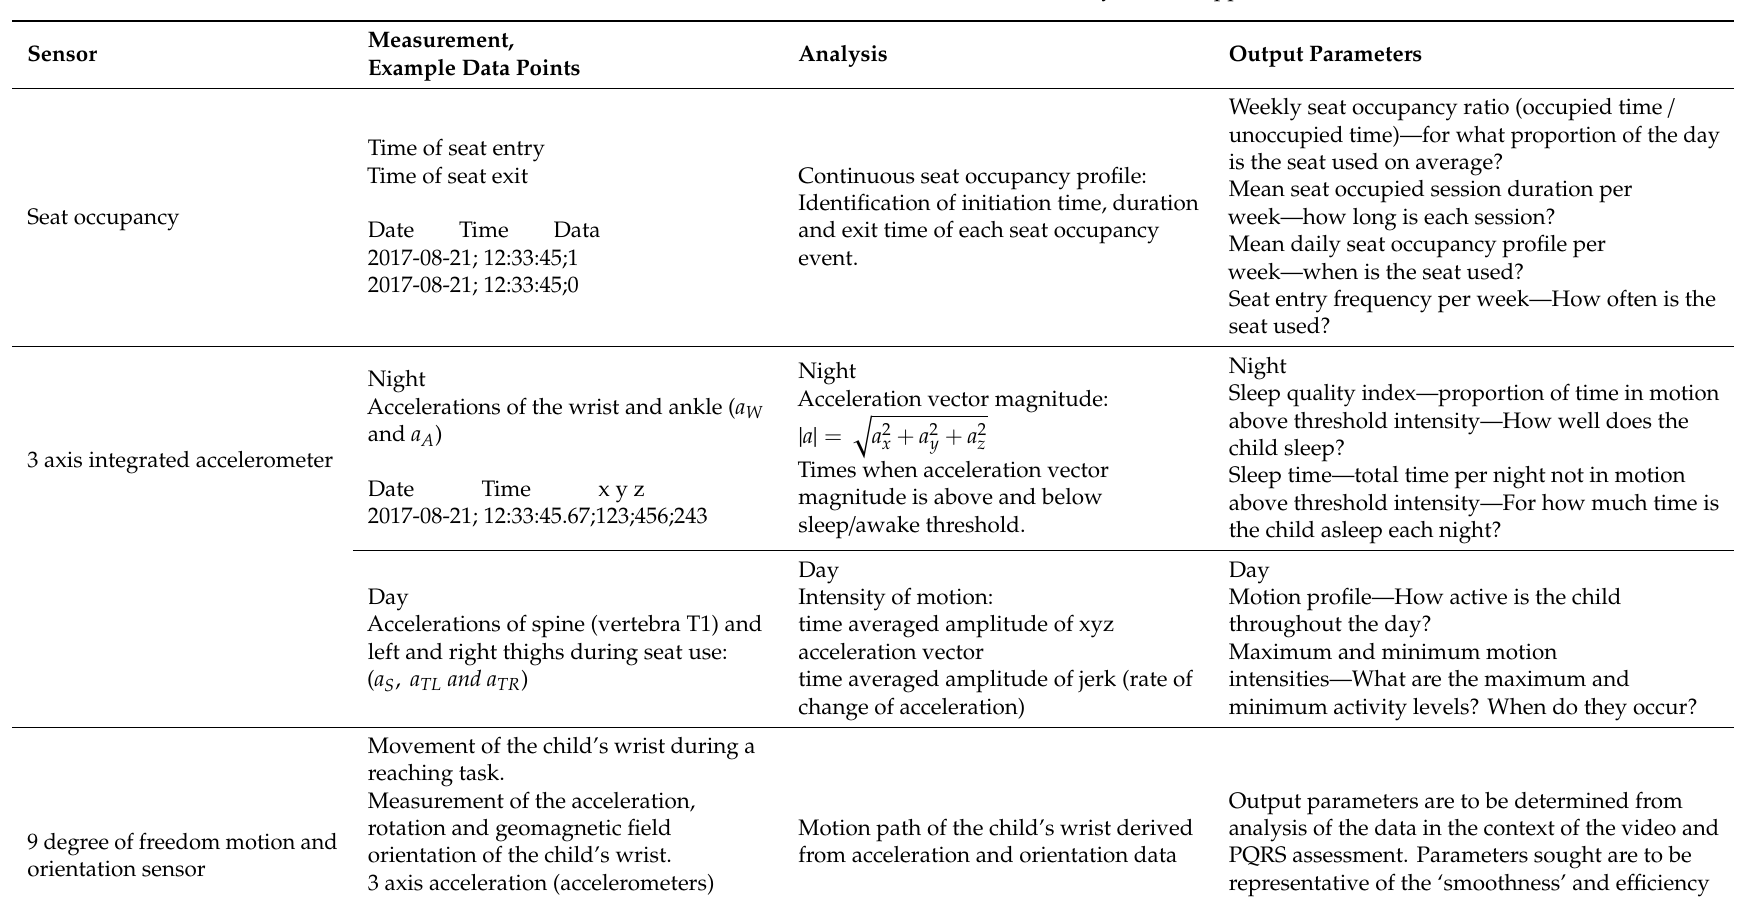
Table 2. A table of sensor data to be collected and the initial analyses to be